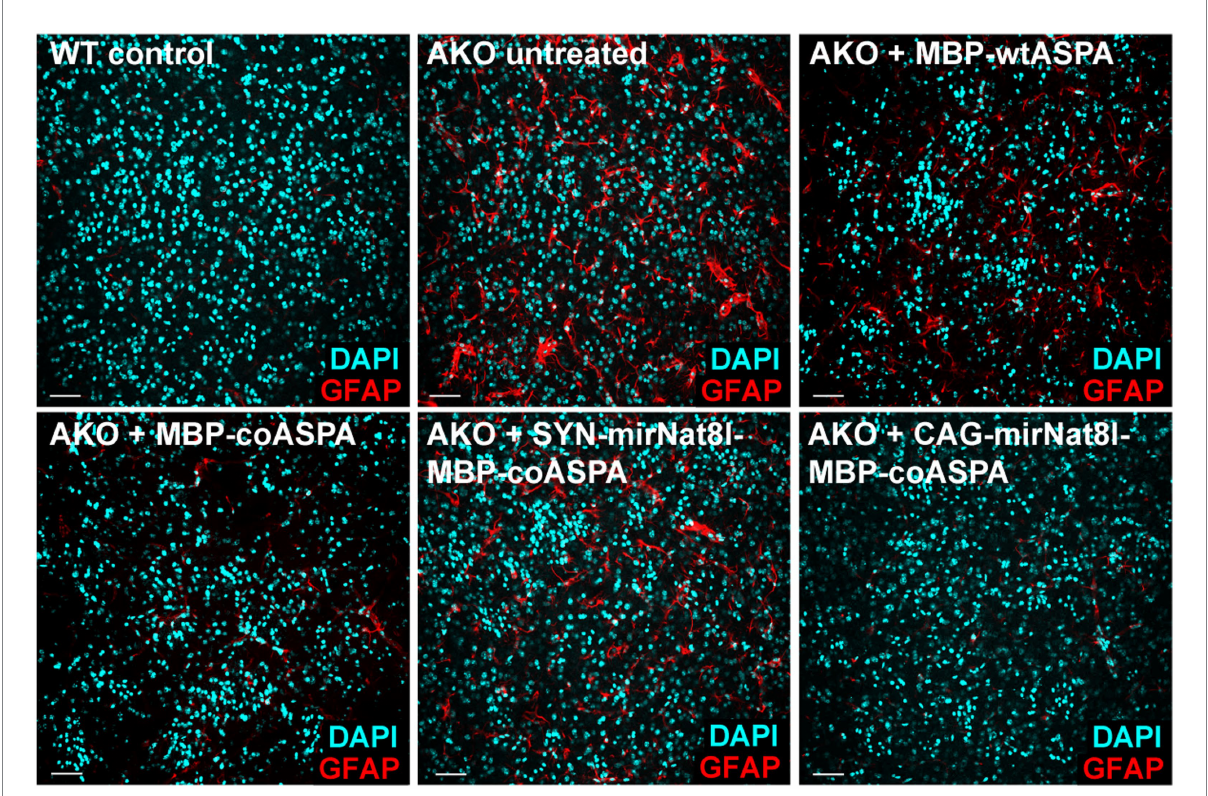
FIGURE 10 Astrogliosis in AKO mice is attenuated following treatment with novel CD gene therapy vectors. Immunohistochemical labelling of GFAP (astrocytes; red) and DAPI (nuclei; cyan) in the striatum of 52-week-old mice showing astrogliosis in untreated AKO mice, which markedly improved in all treatment groups 40 weeks post gene therapy. Scale bars: 50 μ